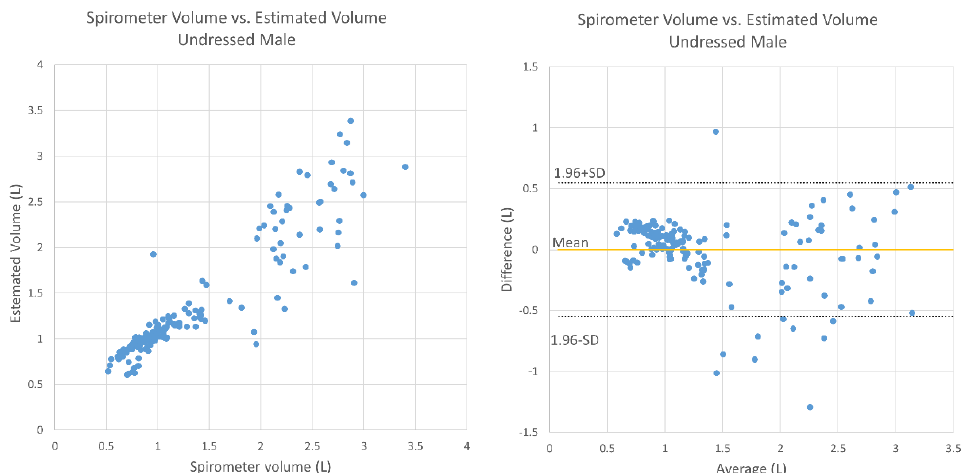
Figure 7. Bland–Altman plot for TV obtained using the spirometer and the estimated TV under undressed conditions (male subjects).